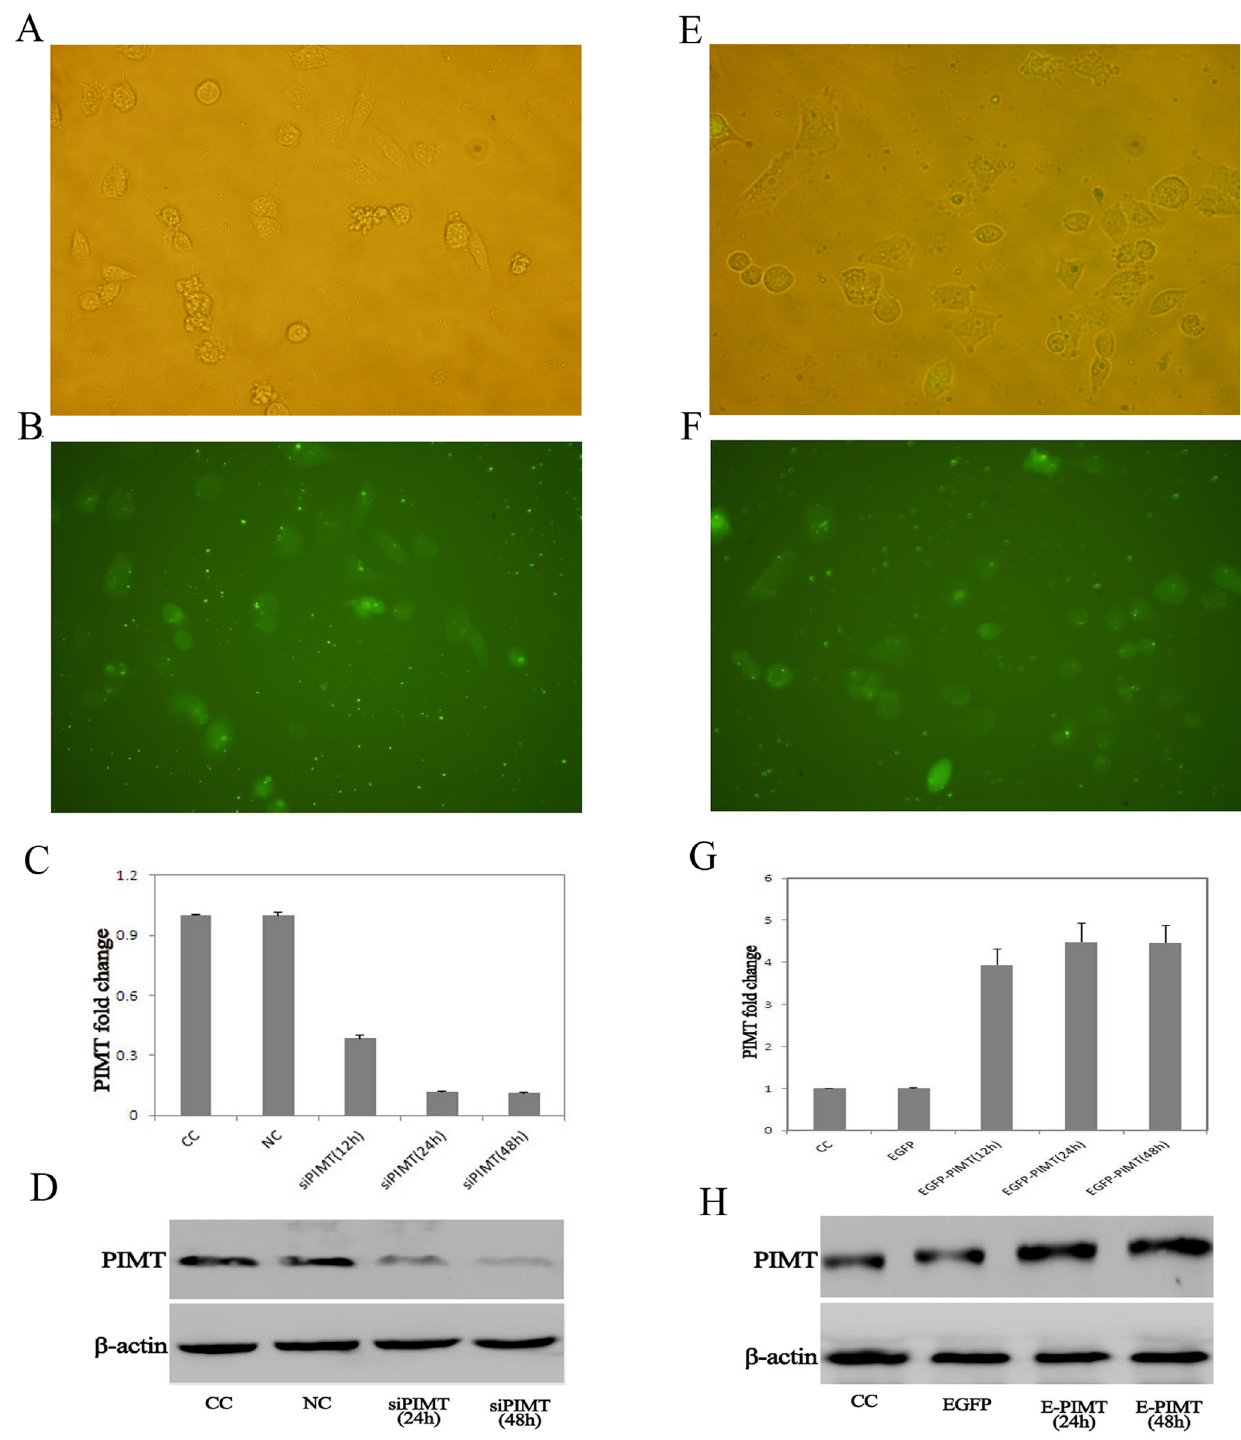
Figure 1. PIMT siRNA and overexpression plasmids transfection HUVEC. A, B: Bright field and fluorescence micrograph displays PIMT siRNA in HUVEC ( 6 200). C: RT-PCR analysis demonstrates PIMT mRNA expression in HUVEC at 12 h, 24 h, and 48 h after transfection. D: Western blot analysis demonstrates PIMT protein expression in HUVEC at 24 h and 48 h after transfection. E, F: Bright field and fluorescence micrograph displays EGFP-PIMT overexpression in HUVEC ( 6 200). G: RT-PCR analysis demonstrates PIMT mRNA expression in HUVEC at 12 h, 24 h, and 48 h after transfection. H: Western blot analysis demonstrates PIMT protein expression in HUVEC at 24 h and 48 h after transfection. CC group: normal control cells; NC group: negative control siRNA cells; siPIMT group: siRNA against PIMT cells; EGFP group: HUVEC carrying EGFP; E-PIMT group: HUVEC carrying both EGFP and PIMT. PIMT: protein L-isoaspartyl methyltransferase; HUVEC: human umbilical vein endothelial cells.